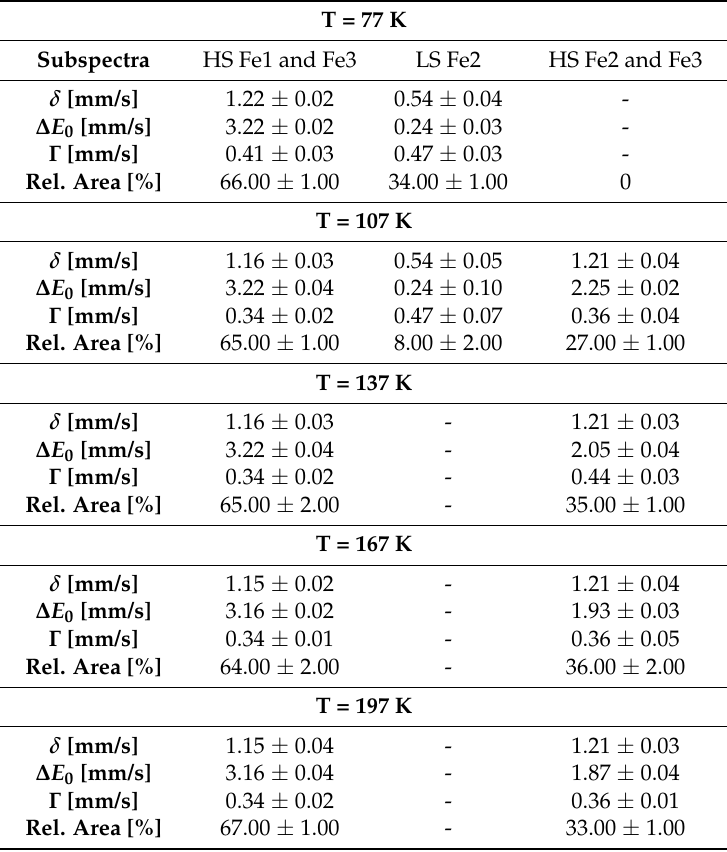
Table 2. 57 Fe Mössbauer parameters of compound 2 at different